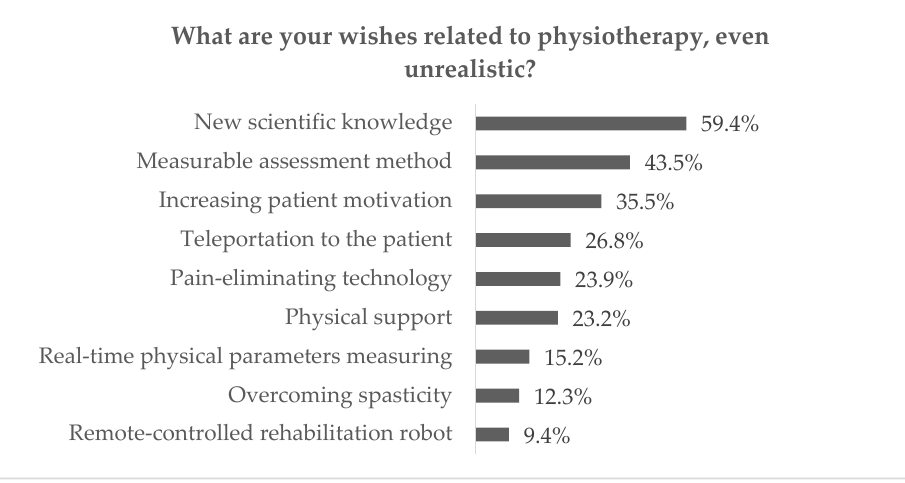
Figure 2. Answers to question 2 from questionnaire research.